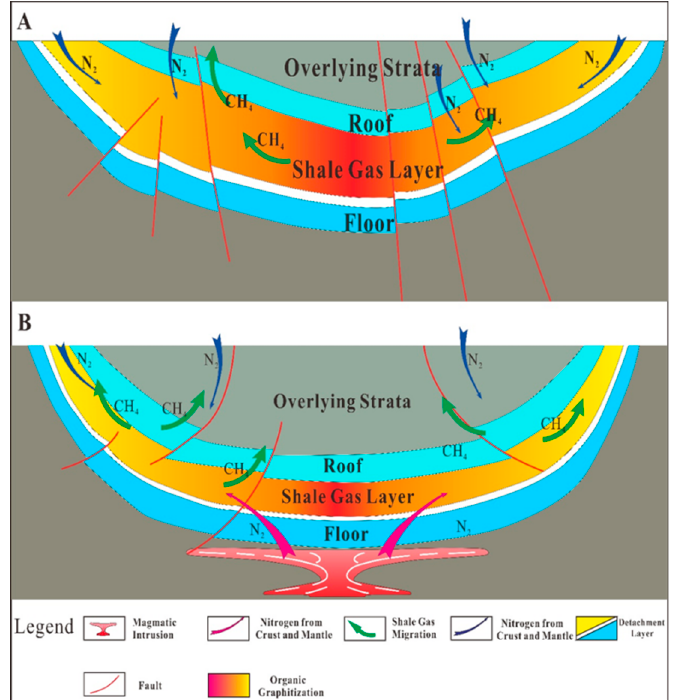
Figure 12. Destruction model for shale gas reservoirs in areas of active plate movement: ( A ) Southeast Chongqing region in the Upper Yangtze area; ( B ) Xiuwu Basin in the Lower Yangtze area.